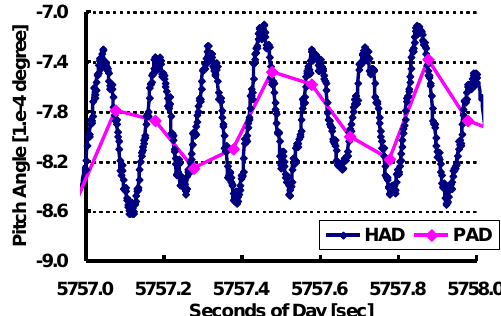
Figure 3. An example of attitude data comparison between PAD and HAD.